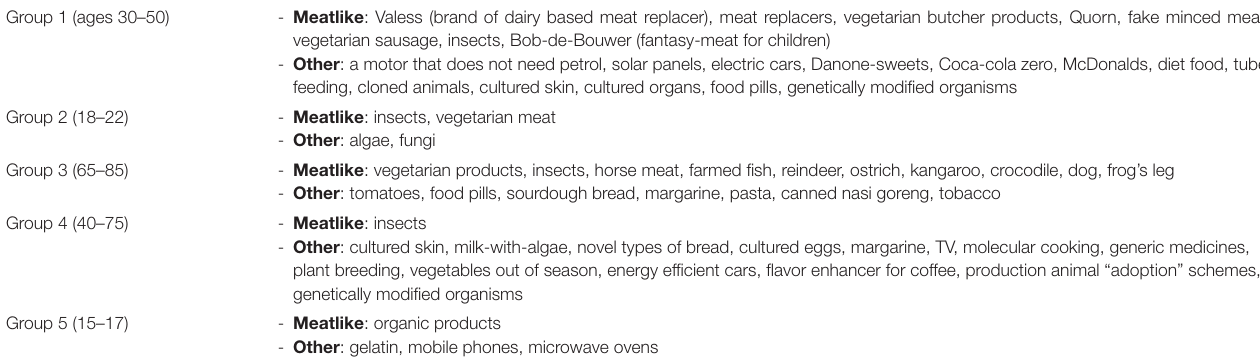
TABLE 1 | Comparisons between cultured meat and other things (most abundant in groups 1, 3, and